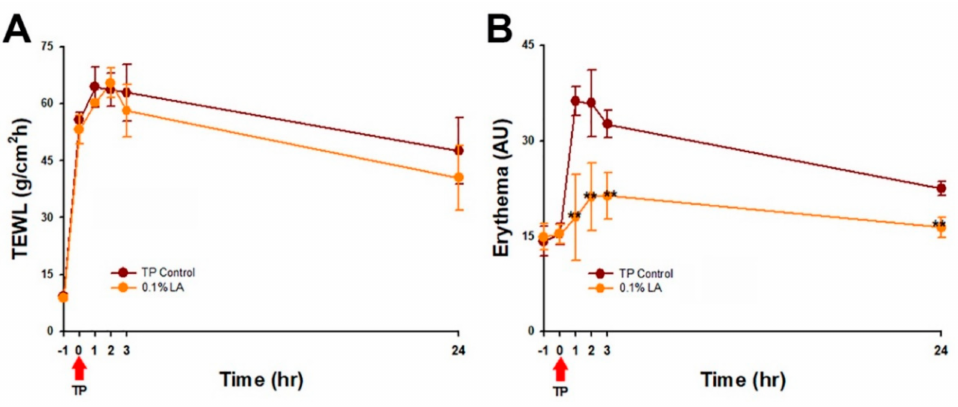
Figure 6. 0.1% LA inhibited tape-stripping induced skin erythema. ( A ) TEWL, and ( B ) skin erythema recovery curve after tape stripping. The red arrow indicated the start of tape-stripping. TP, tape- stripping; LA, lithospermic acid, hr, hour; ** p <